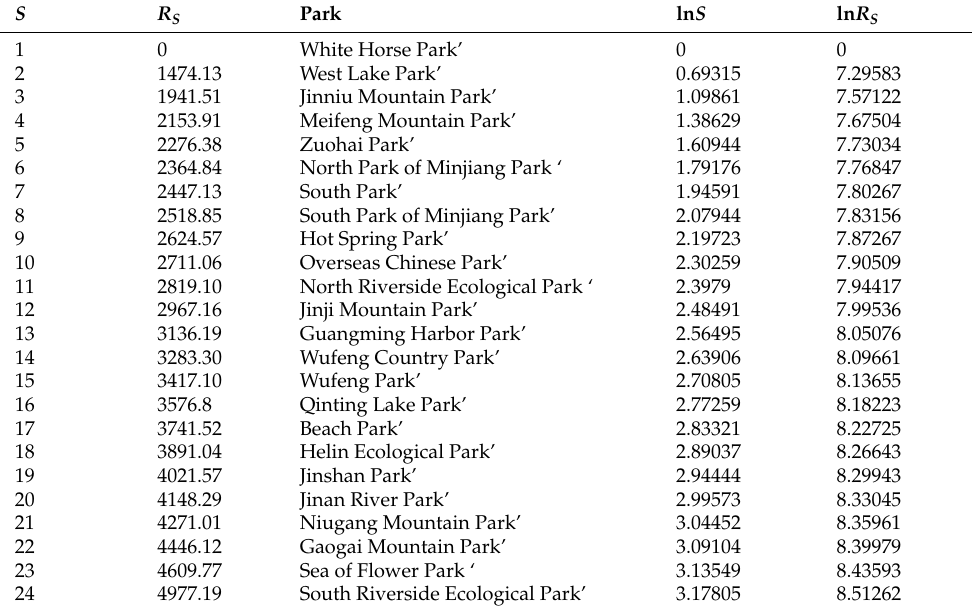
Table A1. Park system aggregation dimensions based on White Horse River Park.